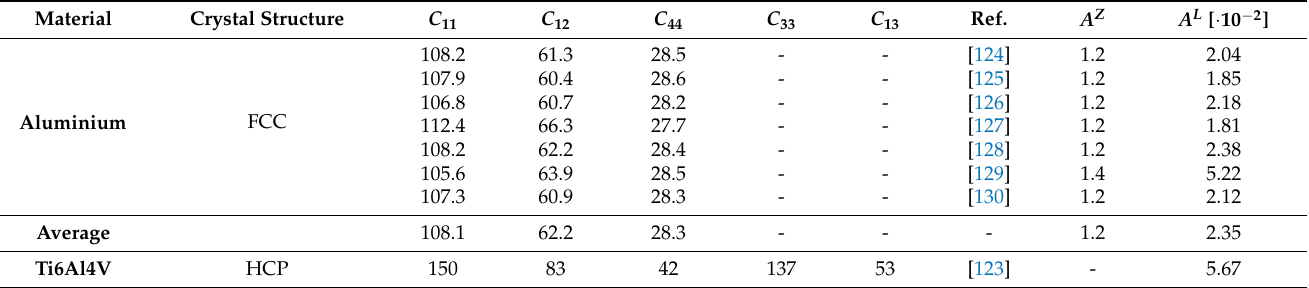
Table 2. Single crystal elastic constants (SCEC) of several engineering alloys in GPa, with their dimensionless calculated Zener ( A z ) and universal ( A L ) anisotropy ratios. For the calculation of A L the Matlab script provided by Kube [120] was used. Material Crystal